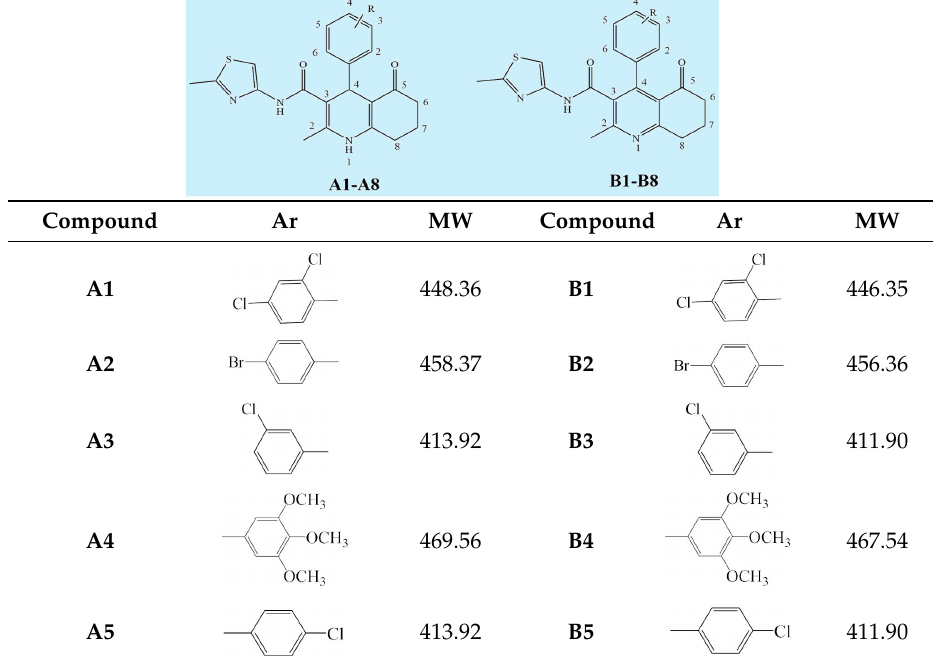
Chemical structures of synthesized 5-oxo-hexahyroquinoline derivatives and their tetrahydroquinoline